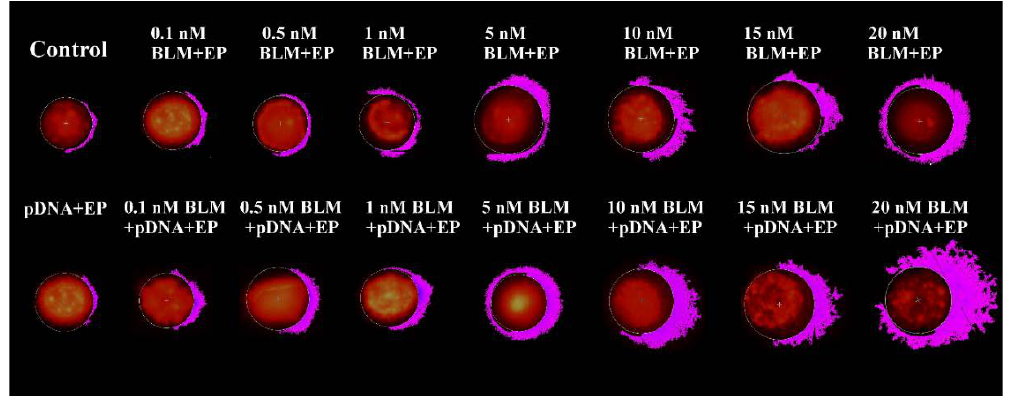
Figure 3. The visualization of Chinese hamster ovary (CHO) cell comets after bleomycin electrotransfer in the absence or the presence of extracellular plasmid